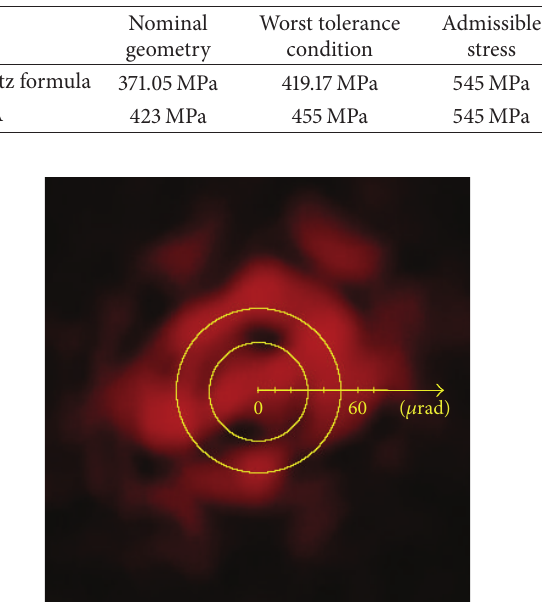
Figure 9: FFDP of CCR mounted in breadboard at 150 ∘ C and exposed to shroud at − 190 ∘